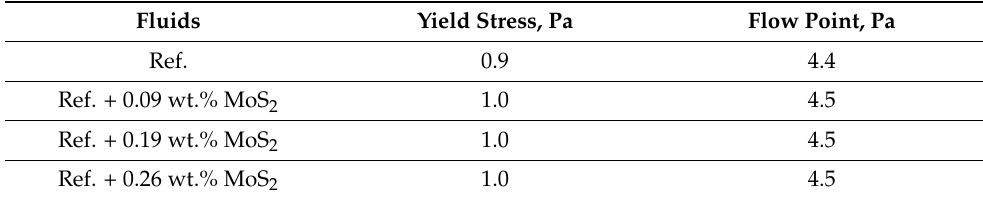
Table 2. Yield and flow point of the drilling fluids.